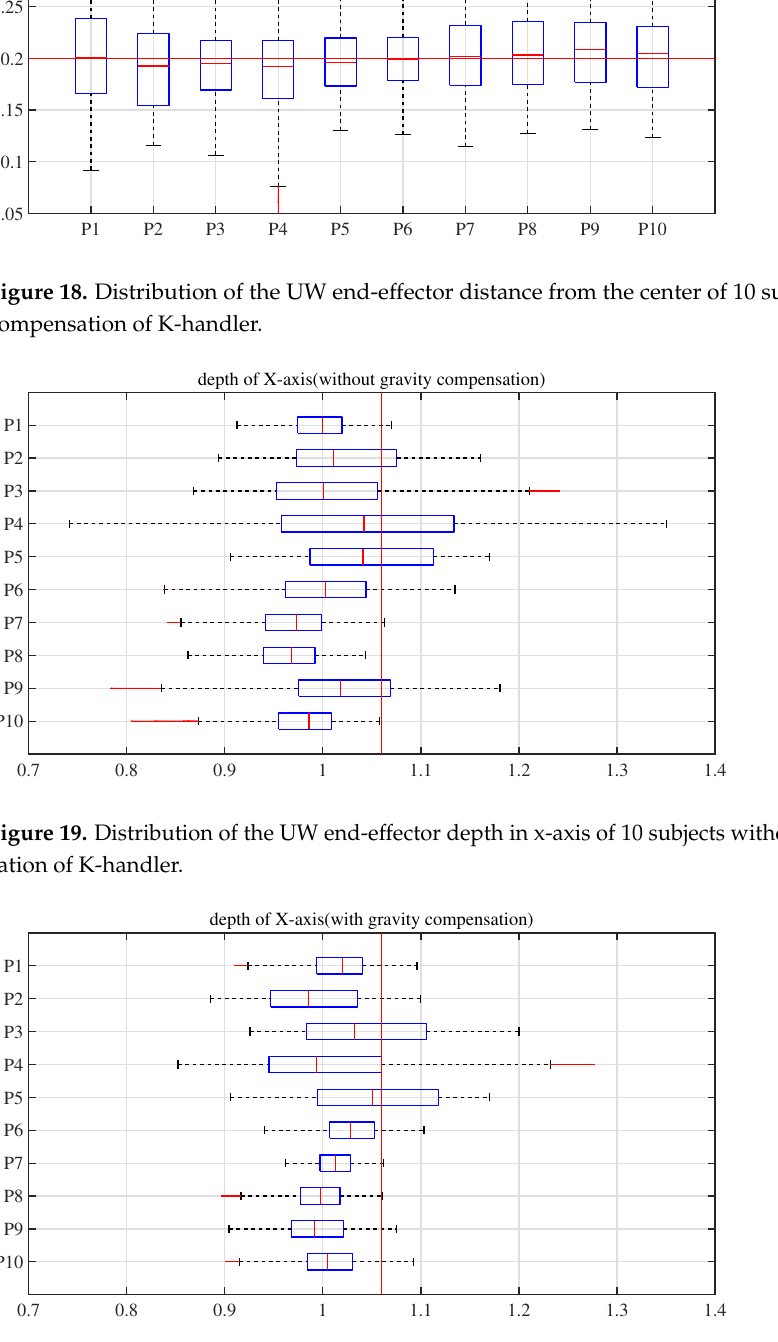
Figure 20. Distribution of the UW end-effector depth in x-axis of 10 subjects with gravity compensa- tion of